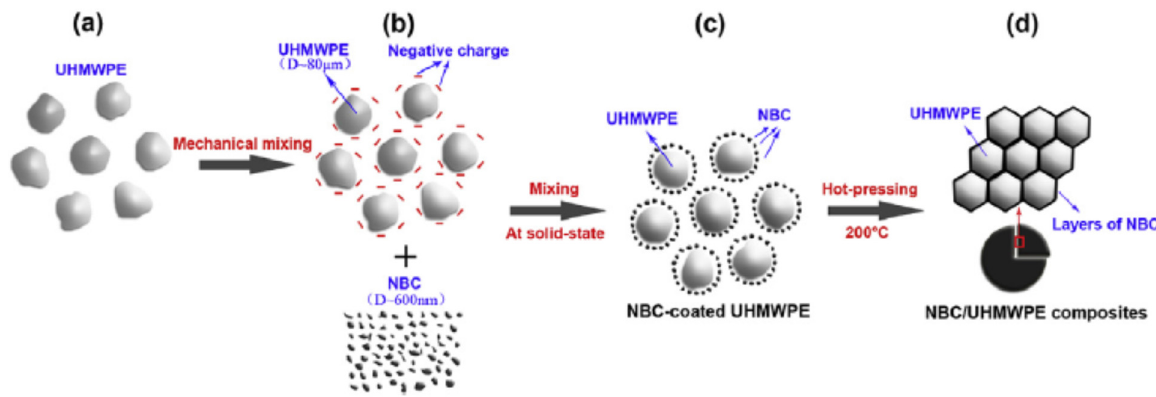
Figure 5. ( a – d ) Schematic representation of the preparation method for composites with segregated morphology [70]. Reproduced with permission from Elsevier Science Ltd. 2016, Elsevier Science Ltd.